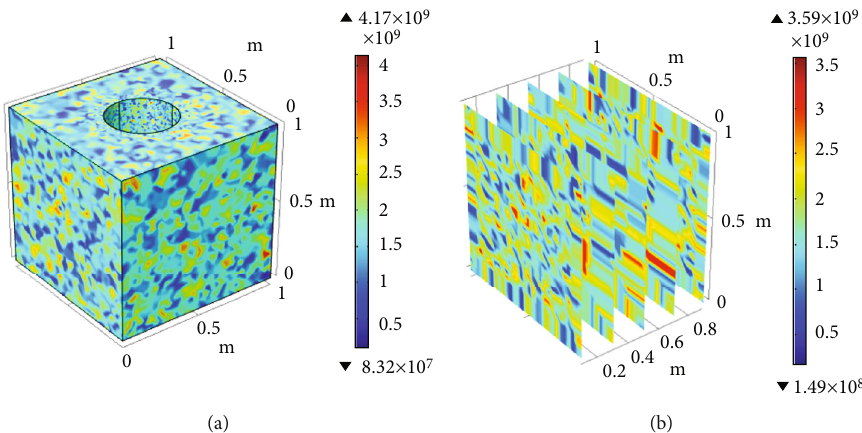
Figure 2: Three-dimensional (3D) mechanical heterogeneity characterization of coal rock: (a) 3D distribution of elastic modulus of coal rock (a) and (b) section of elastic